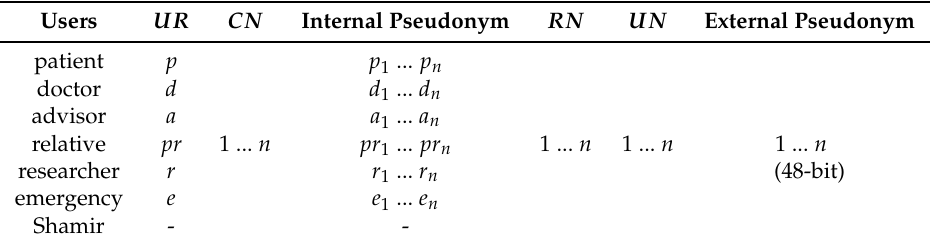
Table 1. Internal and external pseudonyms of users.